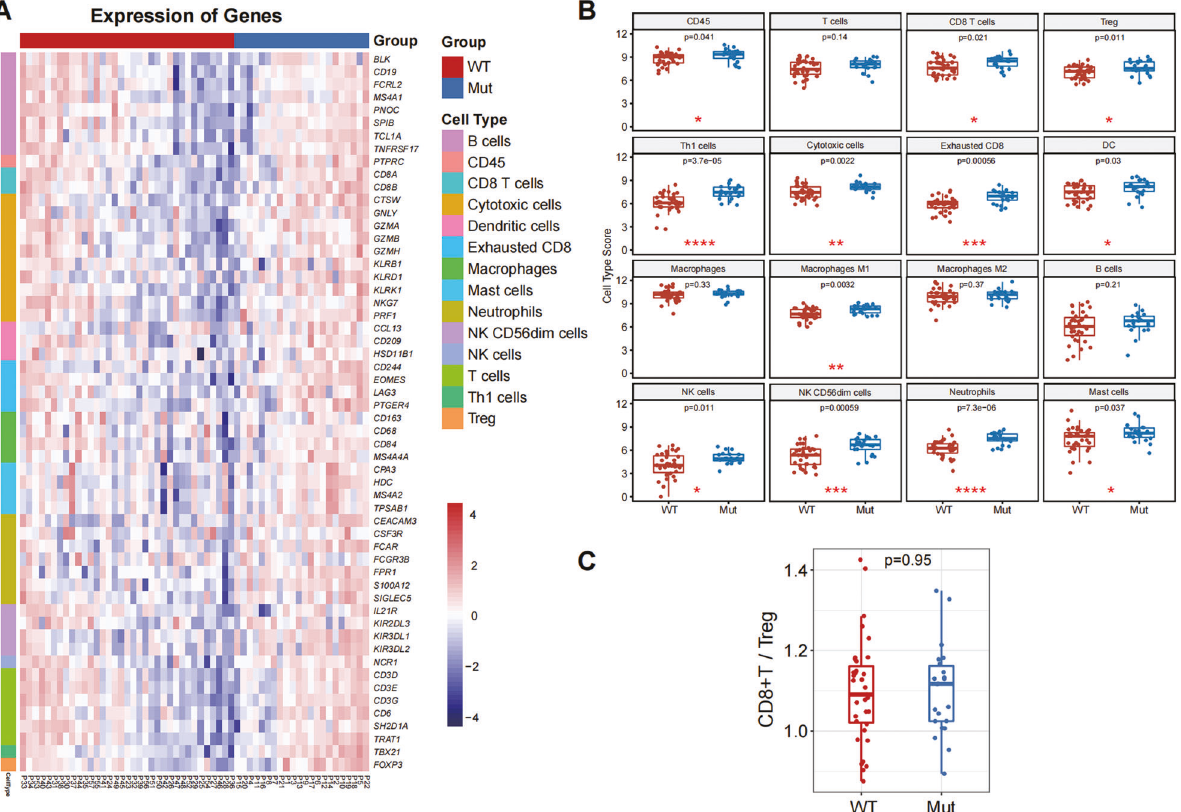
Fig. 1 The immune cell scores in both wild-type and BRAF -mutated NSCLC. A Heatmap of gene transcripts related to various subsets of immune cells in the WT and BRAF mutated NSCLC specimens. B Quantitative analysis of immune cell scores in the WT and BRAF mutated NSCLC specimens. C The ratios of CD8 T cells to Tregs in the WT and BRAF mutated NSCLC specimens.